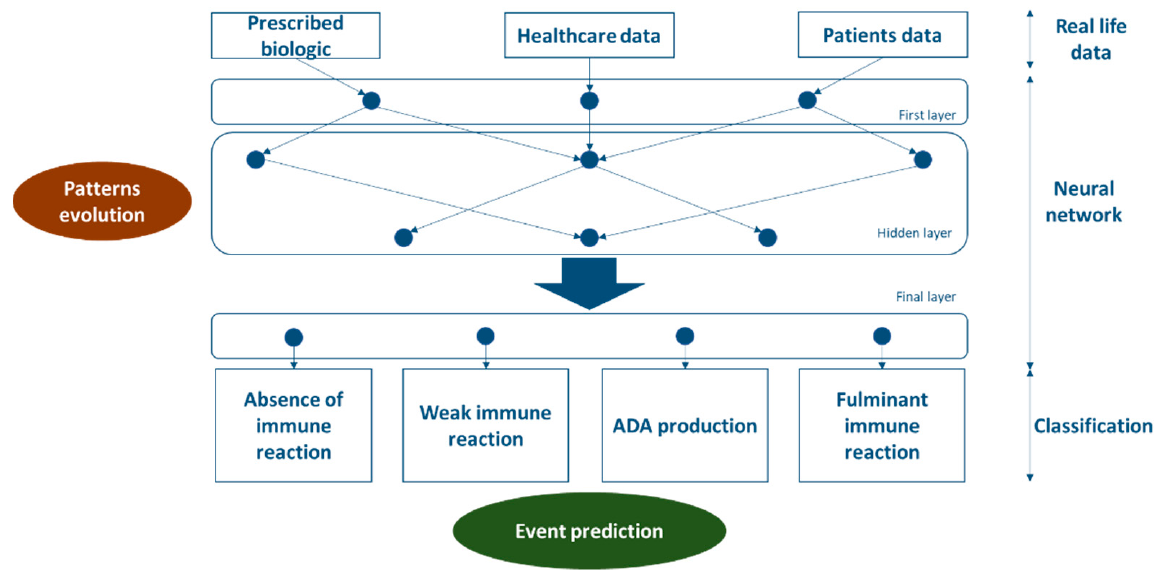
Figure 4. A potentially suitable classification provided by a neural network to assess the immunogenicity of biologic drugs.